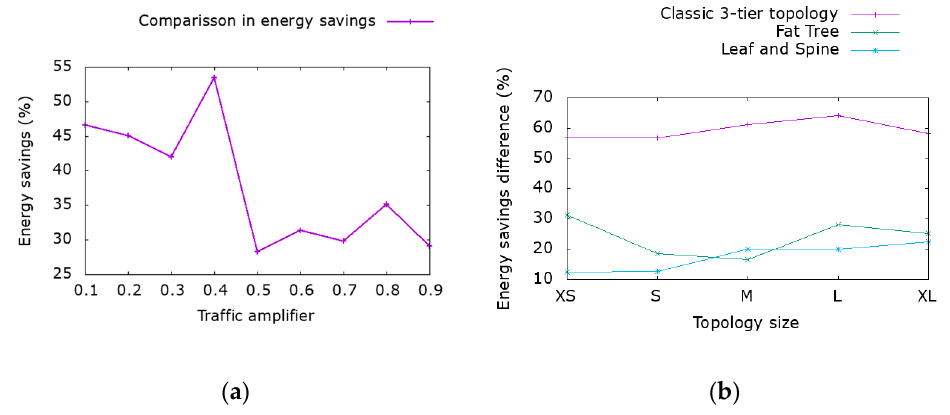
Figure 4. Comparison between approaches based on disabling interfaces and our interface power scale proposal. Difference under ( a ) various workloads on leaf and spine topology, and ( b ) various topologies and number of devices for the same workload.